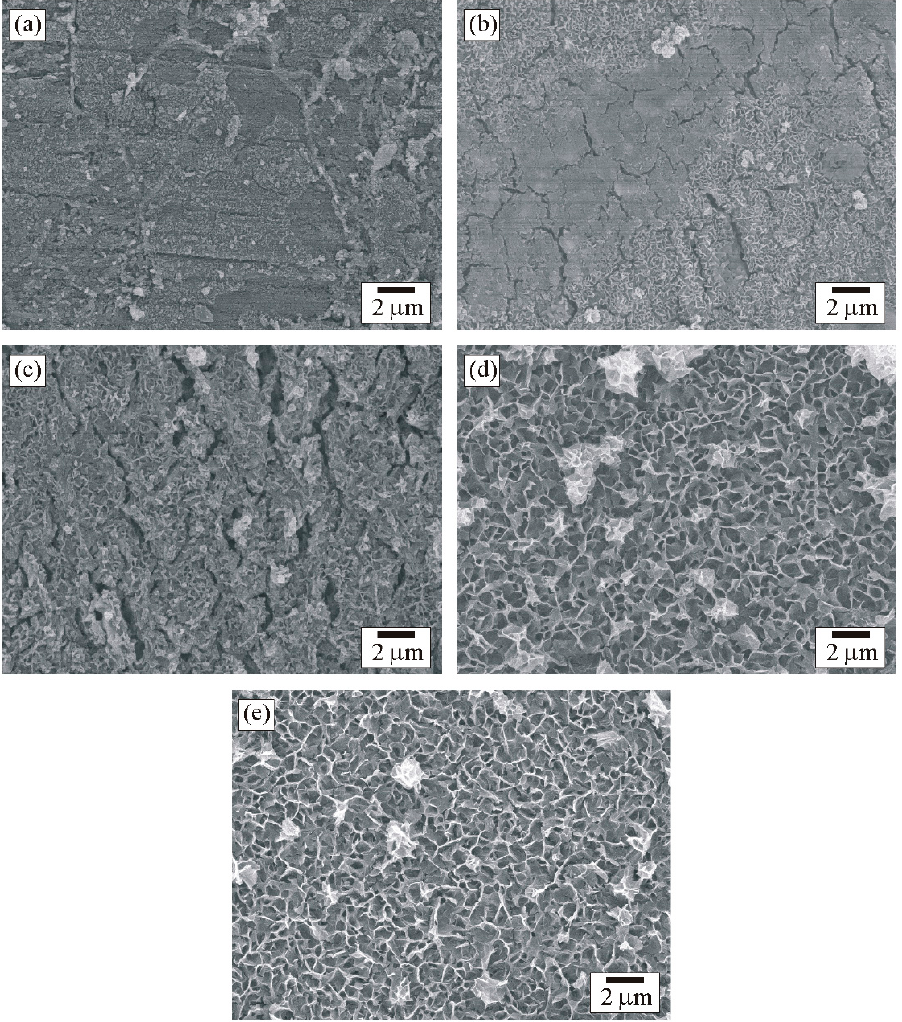
Figure 14. SEM micrograph of the surface of the five zones of the weld after the immersion test: ( a ) Zone A; ( b ) Zone B; ( c ) Zone C; ( d ) Zone D; and ( e ) Zone E.